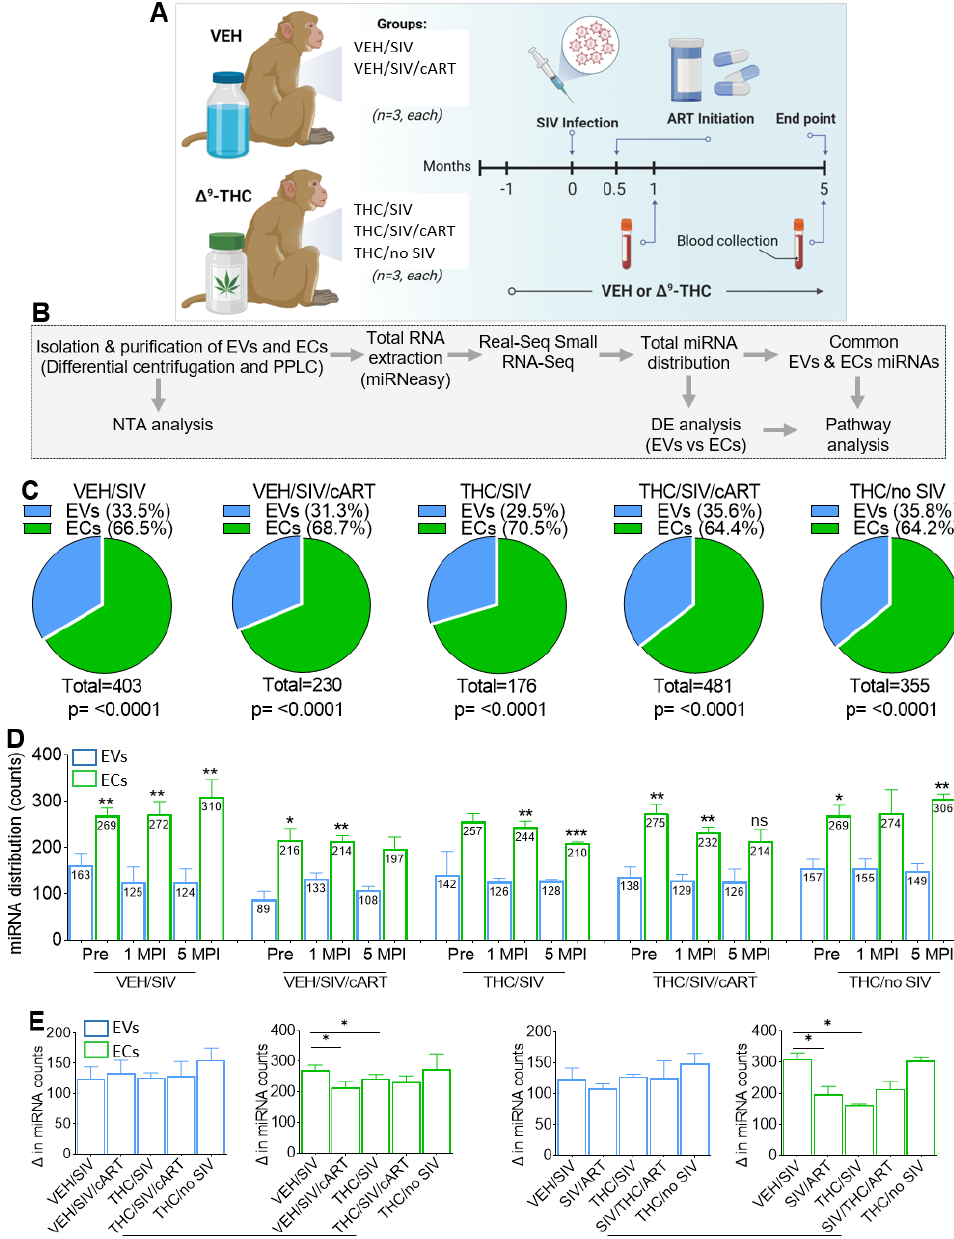
Figure 1. Study workflow for isolation and characterization of blood plasma derived EVs and ECs. ( A ) Description of experimental model. ( B ) Methodological workflow for isolation, and characteri- zation of EVs and ECs. ( C ) Pie chart showing percent detectable miRNAs in the EVs and ECs for each treatment group. ( D ) The number of detectable miRNAs for the EVs and ECs at the Pre, 1 MPI and 5 MPI time points for VEH/SIV, VEH/SIV/ART, THC/SIV, THC/SIV/ART, and THC/no SIV treatment groups. ( E ) The number of detectable miRNAs for the EVs and ECs at 1 MPI (left) and 5 MPI (right) for VEH/SIV, VEH/SIV/ART, THC/SIV, THC/SIV/ART, and THC/no SIV treatment groups. To be included, miRNA count needed to be ≥1 for n = 3 RMs. Binary students ’ t tests (Welch’s correction) were used to determine significant differences between EVs and ECs for each of the time points in each group. *** p < 0.005, ** p < 0.01, * p < 0.05, and ns = non-significant.